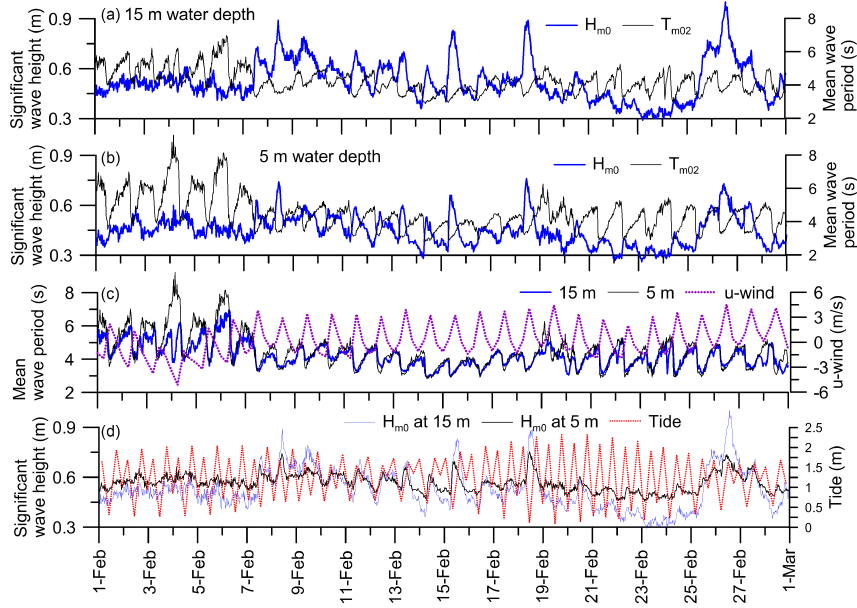
Figure 5. (a) Plot of significant wave height and mean wave period at 15m water depth, (b) at 5m water depth, (c) mean wave period at 15 and 5m water depth and cross-shore wind speed and (d) significant wave height at 15 and 5m water depth and the tide.